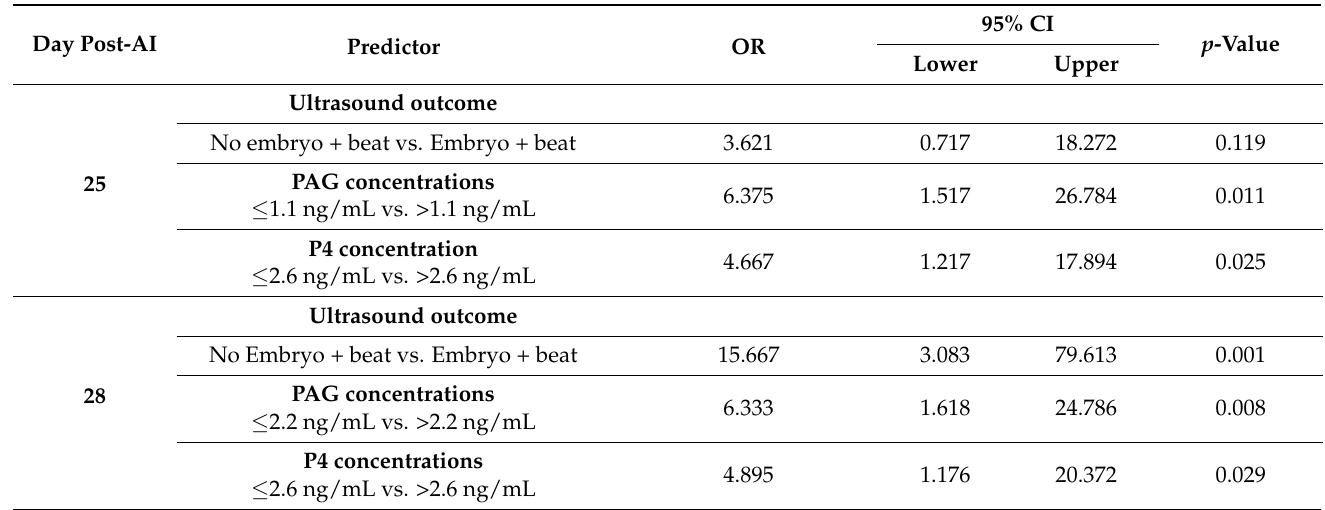
Table 3. Univariate models to evaluate the predictors of mortality in buffalo cows at days 25 and 28 post-AI. Day